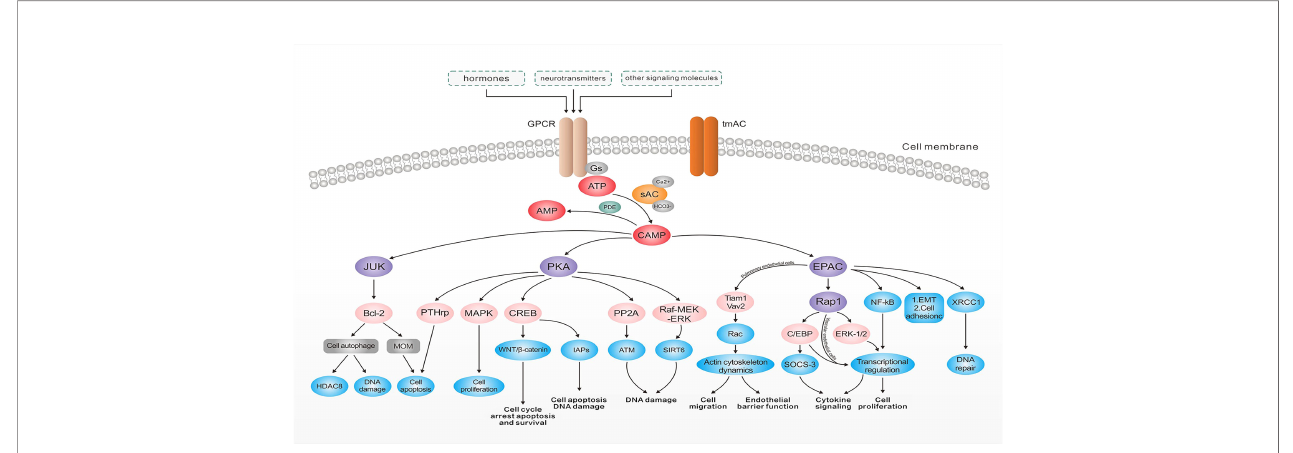
FIGURE 2 | The roles of adenylate cyclases in tumorigenesis. After binding to G protein-coupled receptors, hormones, neurotransmitters, and a number of other signaling molecules, cyclic adenosine 3 ′ ,5 ′ -monophosphate (cAMP) is generated from ATP by the action of adenylate cyclase and degraded to the 5 ′ -cAMP by the action of cyclic nucleotide phosphodiesterase (PDE). cAMP can increase DNA damage via a range of pathways and plays an important role in endoskeletal remodeling, cell proliferation, adhesion, and EMT. It also regulates the permeability of the mitochondrial outer membrane, affecting cell survival, activates the WNT/ b - catenin pathway, and regulates the processes of cell cycle arrest, apoptosis, survival, and DNA damage. cAMP signaling pathways can also protect cancer cells from apoptosis after exposure to radiation or chemotherapeutic agents through related pathways. Abbreviations: EGFR, epidermal growth factor receptor; tmAC, transmembrane adenylate cyclase; Gs, stimulatory G-protein; sAC, soluble adenylate cyclase; ATP, adenosine triphosphate; PDE, phosphodiesterase; cAMP, cyclic adenosine phosphate; PKA, protein kinase A; JNK, c-Jun N-terminal kinase; Bcl-2, B-cell lymphoma-2; MOM, mitochondrial outer membrane; HDAC8, histone deacetylase 8; MAPK, mitogen-activated protein kinase; CREB, cAMP response element-binding proteins; IAPs, inhibitor of apoptosis proteins; PP2A, protein phosphatase 2A; ATM, the ataxia – telangiectasia – mutated protein; Raf-MEK-ERK, Raf/mitogen-activated extracellular signal-regulated kinase/extracellular signal- regulated kinase; EPAC, cAMP-EGF-I/II; ERK, extracellular signal-regulated kinase; XRCC1, X-ray repair complementing defective repair in Chinese hamster cell 1; EMT, epithelial-mesenchymal transition; SOCS-3, suppressor of cytokine signaling 3; C/EBP, CCAAT/enhancer-binding